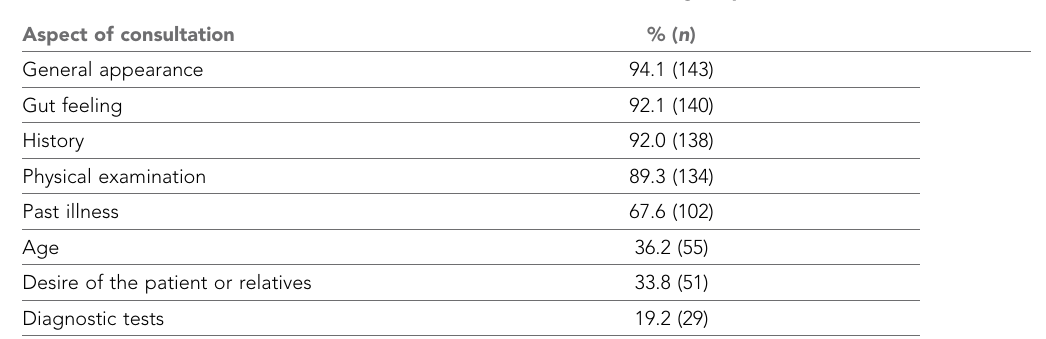
Table 2. Importance of aspects of the history and physical examination for the clinical decision making in the self- reported cases of referred